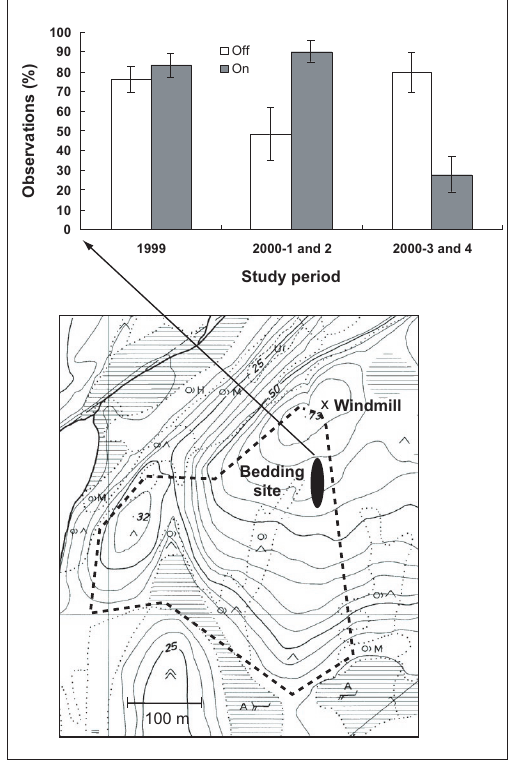
Fig. 2. The total % (bars: standard error of the mean) of observed lying bouts at the most frequently used bedding site of the wind turbine enclosure with rotor movement off and on. (Permission no. Ugland IT